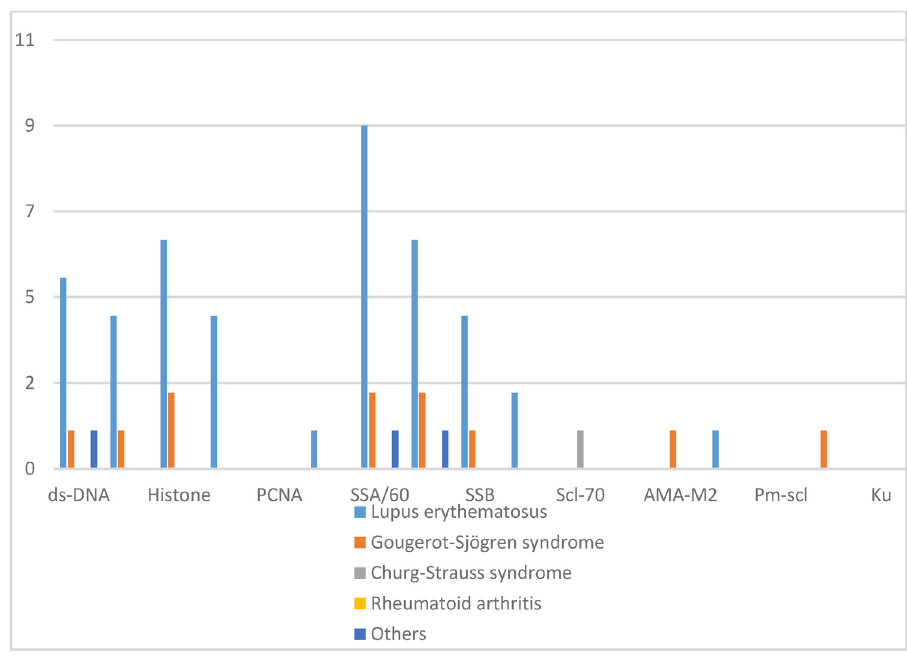
Figure 6: Immunological results according to the presence of ANA in systemic diseases.